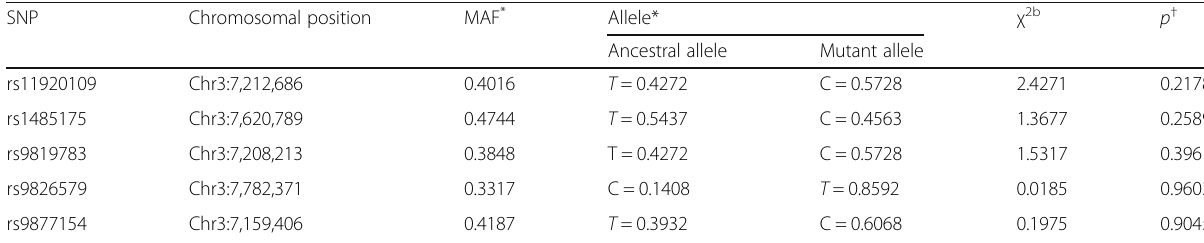
Table 2 Basic Information of the Selected SNPs SNP Chromosomal position MAF * Allele* χ 2b p † Ancestral allele Mutant